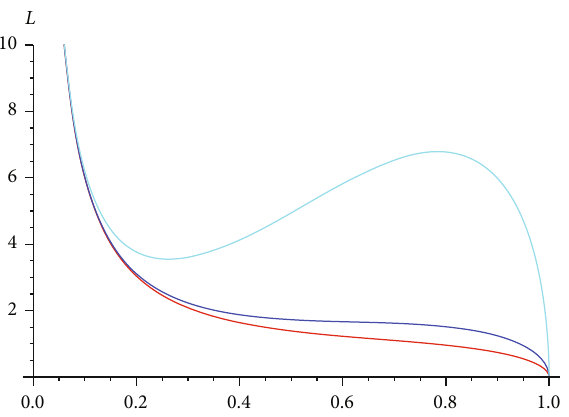
Figure 3: This is a parametric plot of U v/s L . The plot CP + SE indicates the pro fi le of the potential (with static energy subtracted) to be Coulombic at large distances. At small distance, the pro fi le exhibits a linear dependence. However, noncommutativity has a tendency to increase the linear e ff ect. The values used are m = 1 and λ = 4 π 2 . The red line stands for the value θ = 0 : 2 while the blue line indicates θ = 0 : 3